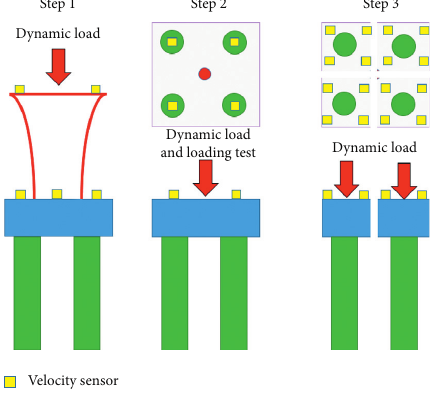
Figure 5: Three test stages.